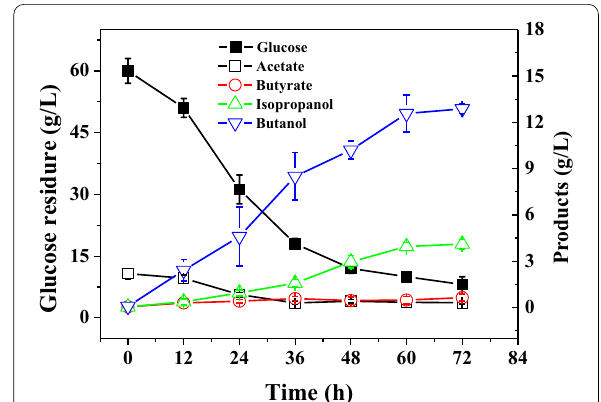
Fig. 4 BI fermentation by C. beijerinckii XH29 in P2 medium supplemented with